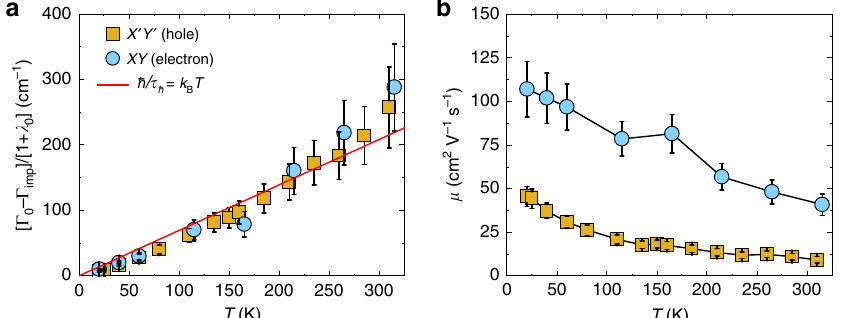
Fig. 5 Static charge transport properties. a Inverse inelastic quasiparticle scattering time of conduction holes and electrons as function of temperature, both following the universal Planckian limit ( _ τ (cid:2) 1 _ ¼ k B T ). b Calculated DC mobility for both charge carriers as function of temperature. The error bars re fl ect the maximum proportional error calculated from the errors on individual fi tting parameters (see Supplementary Note 2).